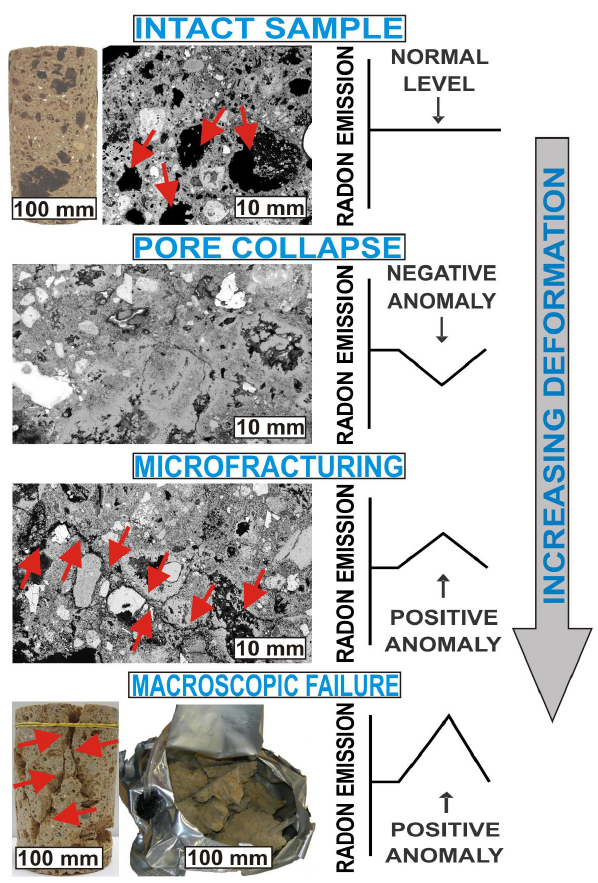
Figure 2. Schematic overview of the relationship between TRSN sample deformation and radon emission as determined by previous studies (Hudyma et al., 2004; Tuccimei et al., 2006, 2009, 2011). Back-scattered electron (BSE) images were obtained using a field- emission scanning electron microscopy (FE-SEM) at the HP-HT Laboratory of Experimental Volcanology and Geophysics of the Is- tituto Nazionale di Geofisica e Vulcanologia in Rome (Italy). Large cavities, vugs and vesicles (i.e. lithophysae) are indicated for the intact sample. Due to pore collapse, no lithophysae are observable for the densely compacted sample; consequently, radon emission decreases. In contrast, microfractures are formed prior to rock fail- ure, causing a positive geochemical anomaly. After rupture, the for- mation of macroscopic exhaling surface further increases the radon